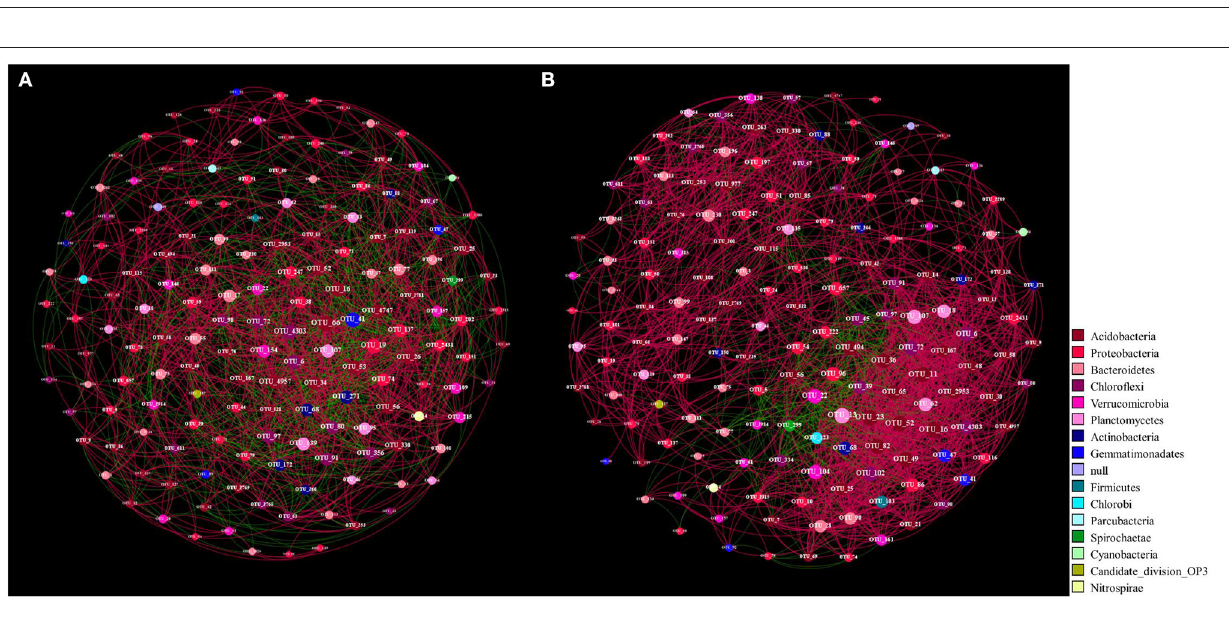
FIGURE 6 | Networks of operational taxonomic units (OTUs) (relative abundance > 0.1%) in the rhizospheres of the 0-kg silicon dioxide (SiO 2 ) ha − 1 (Si0) (A) and 200-kg SiO 2 ha − 1 (Si200) application treatment (B) included in the three sugarcane varieties based on correlation analysis. A connection stands for a strong (Spearman’s r > 0.6) and significant ( P < 0.05) correlation. The networks are colored by phylum. For each panel, the size of each node is proportional to the number of connections (i.e., degree). A red edge indicates a positive interaction between two individual nodes, and a green edge indicates a negative